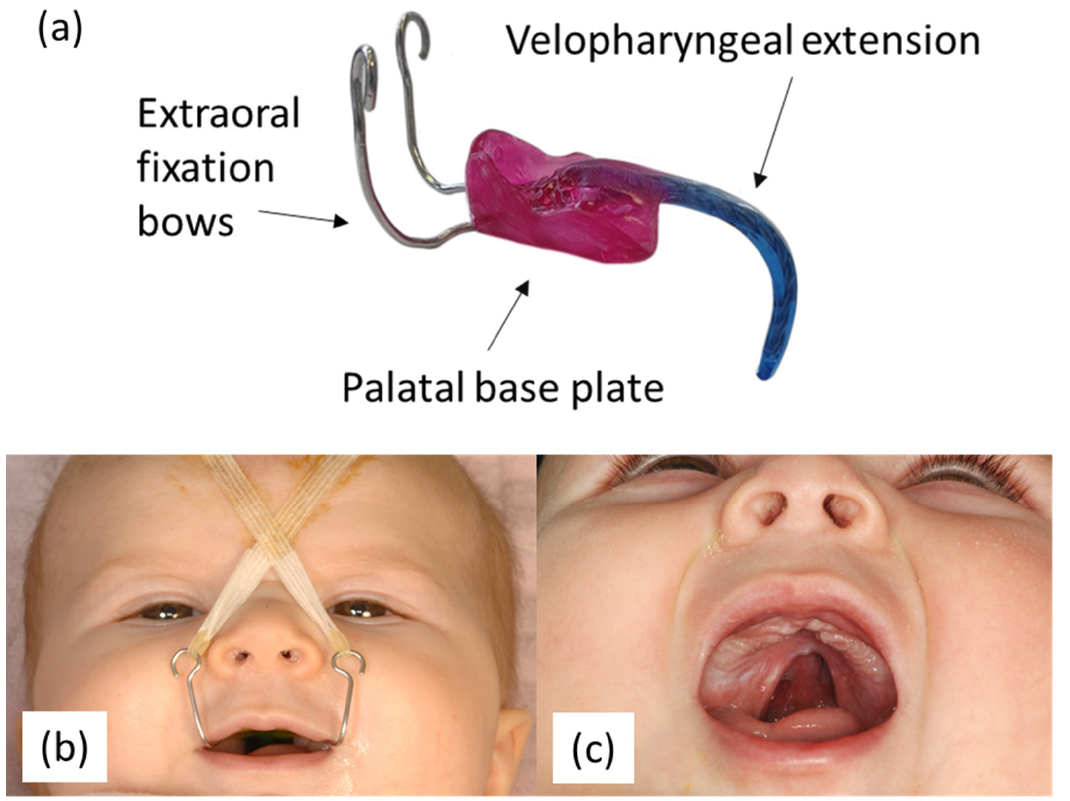
Figure 1. Tübingen palatal plate (TPP) orthodontic appliance: ( a ) construction of the TPP bases on two extraoral fixation bows, a velopharyngeal extension (blue) and a palatal base plate (pink); ( b ) Robin sequence patient with inserted TPP and its fixation by extraoral tapes; ( c ) Robin sequence patient without the inserted TPP showing the cleft palate.